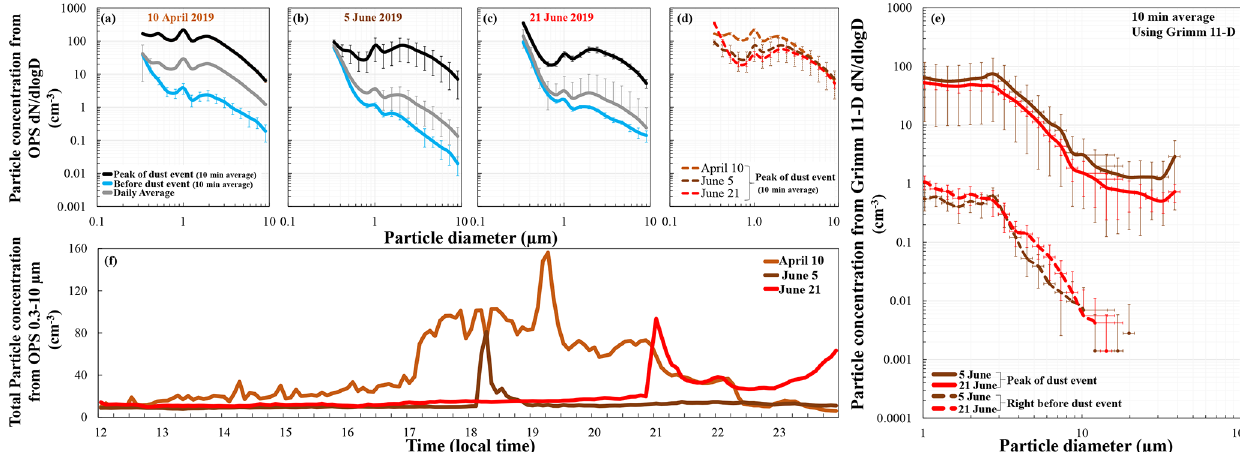
Figure 4. Changes in the particle size distribution based on optical particle diameter, as measured by OPS, during the three dust events: 10 April (a) , 5 June (b) , and 21 June (c) . The colored lines show the peak of the dust (10min average for time with the highest concentration – black), a time before the dust reached the station (10min average – light blue), and the daily average (gray). Panel (d) shows a comparison of the three size distributions at the peak of the dust (10min average for the time with the highest concentration). Panel (e) shows a comparison of the 10min average size distribution from 5 June (dark brown) and 21 June (red), as measured with the Grimm 11-D instrument, at the peak of the dust event (straight line) and right before the dust event (dashed line). Panel (f) presents the total particle number concentration (0.3–10µm) from OPS for each of the dust events for 10 April (light brown), 5 June (dark brown), and 21 June